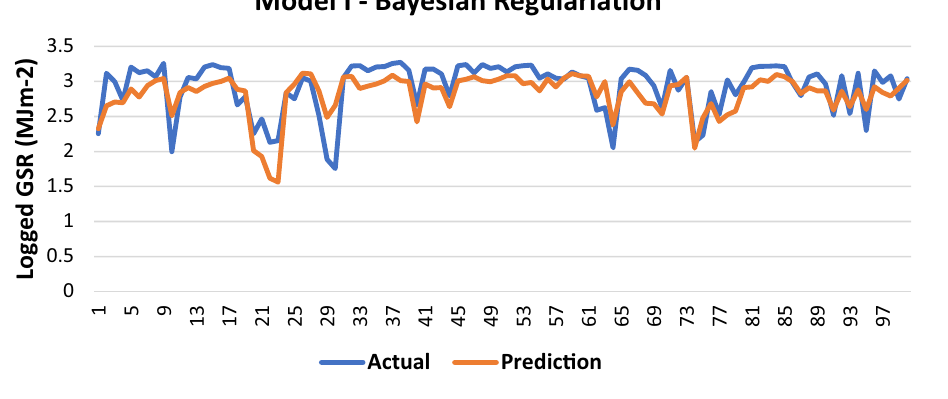
Figure 5. Graph of Actual and Predicted GSR (Model I—BR).